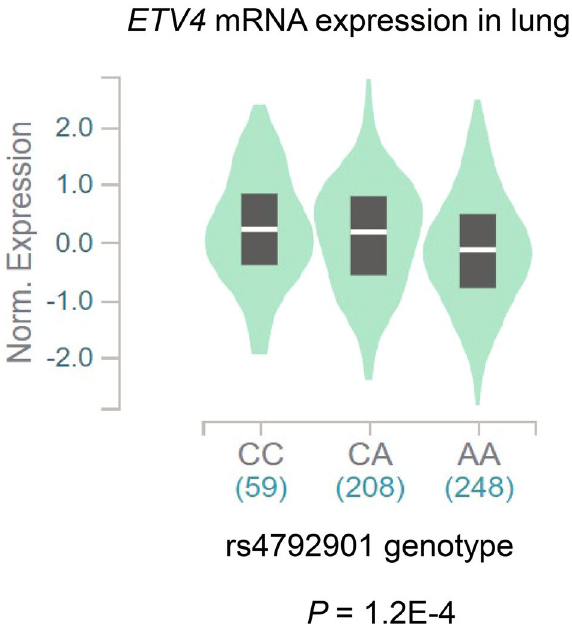
Figure 3. Expression quantitative trait loci (eQTL) analysis. The Genotype-Tissue Expression (GTEx) dataset includes 54 different non-diseased human tissue sites. The rs4792901 genotype is significantly associated with ETV4 mRNA expression in lungs. The width of the violin plots indicates the sample density. The black boxes in the center represent the interquartile range. The white bars in the middle are the median values.